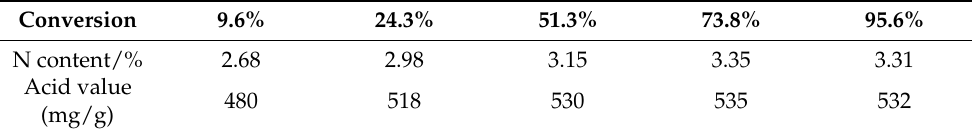
Table 2. Copolymer composition in experimental group 4 at various conversion rates.